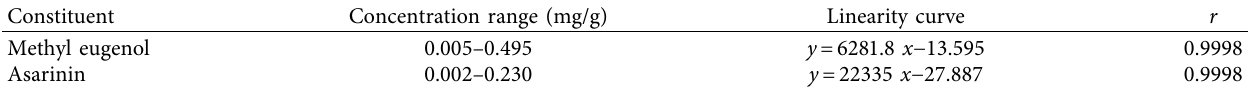
Table 4: Linear range and detection